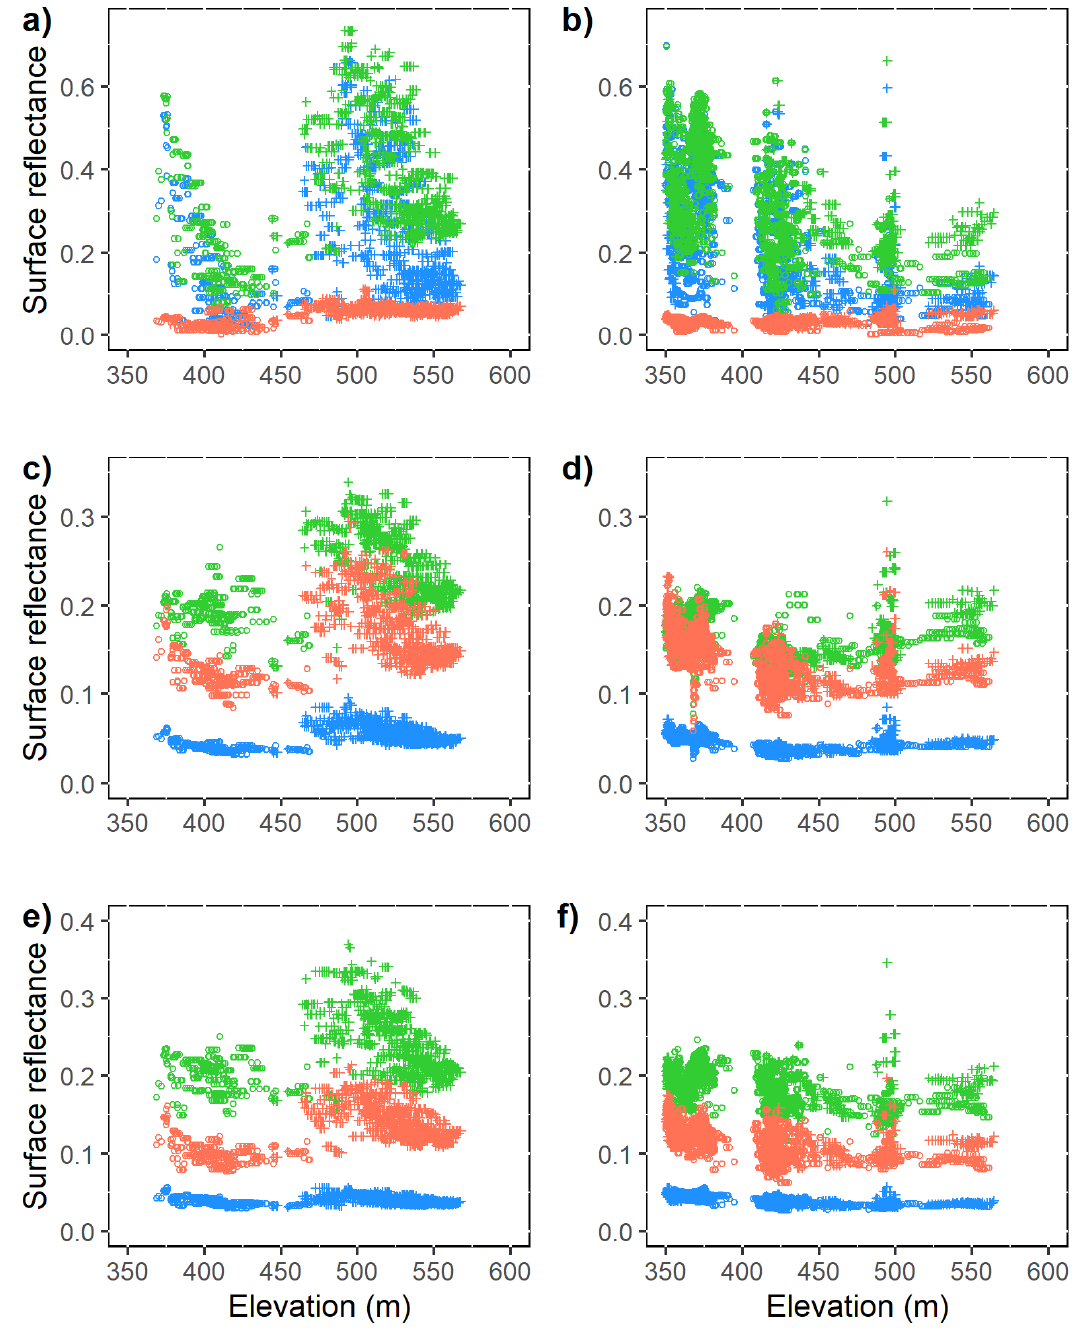
Figure 10. Relationships between surface reflectance (visible band in blue, near-infrared band in green, and shortwave infrared band in orange) and elevation in March (upper panel), May (middle panel), and August (lower panel) 2014. Trees in the northern aspect are represented by an open circle, and in the southern aspect, by a cross symbol. Sub-plot ( a , c , e ) are for deciduous forests, while sub-plot ( b , d , f ) are for evergreen forests.